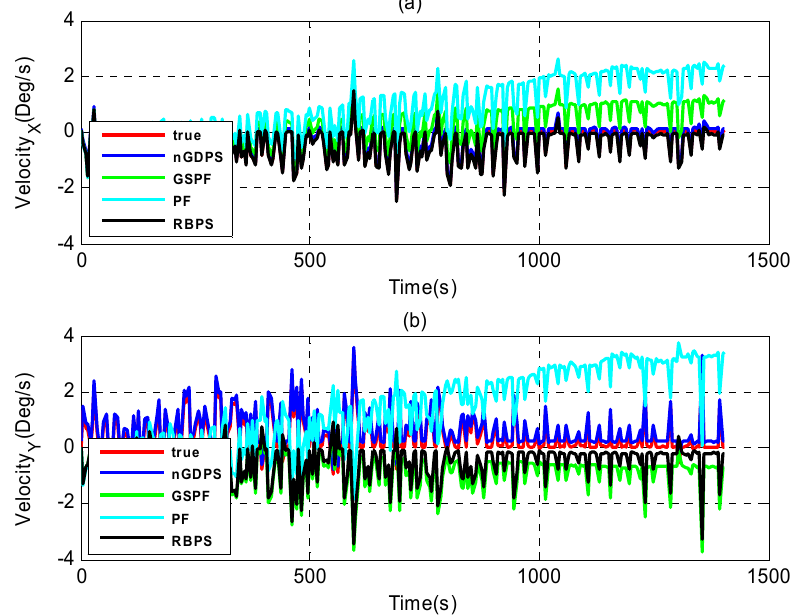
Figure 7. Estimate velocity results of nGDPS, GSPF and RBPS versus true vehicle state in (X, Y)-coordinates. ( a ) X-coordinates; ( b ) Y-coordinates.